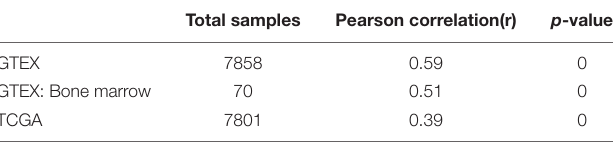
TABLE 1 | The co-expression of ASPH with GSK3B .